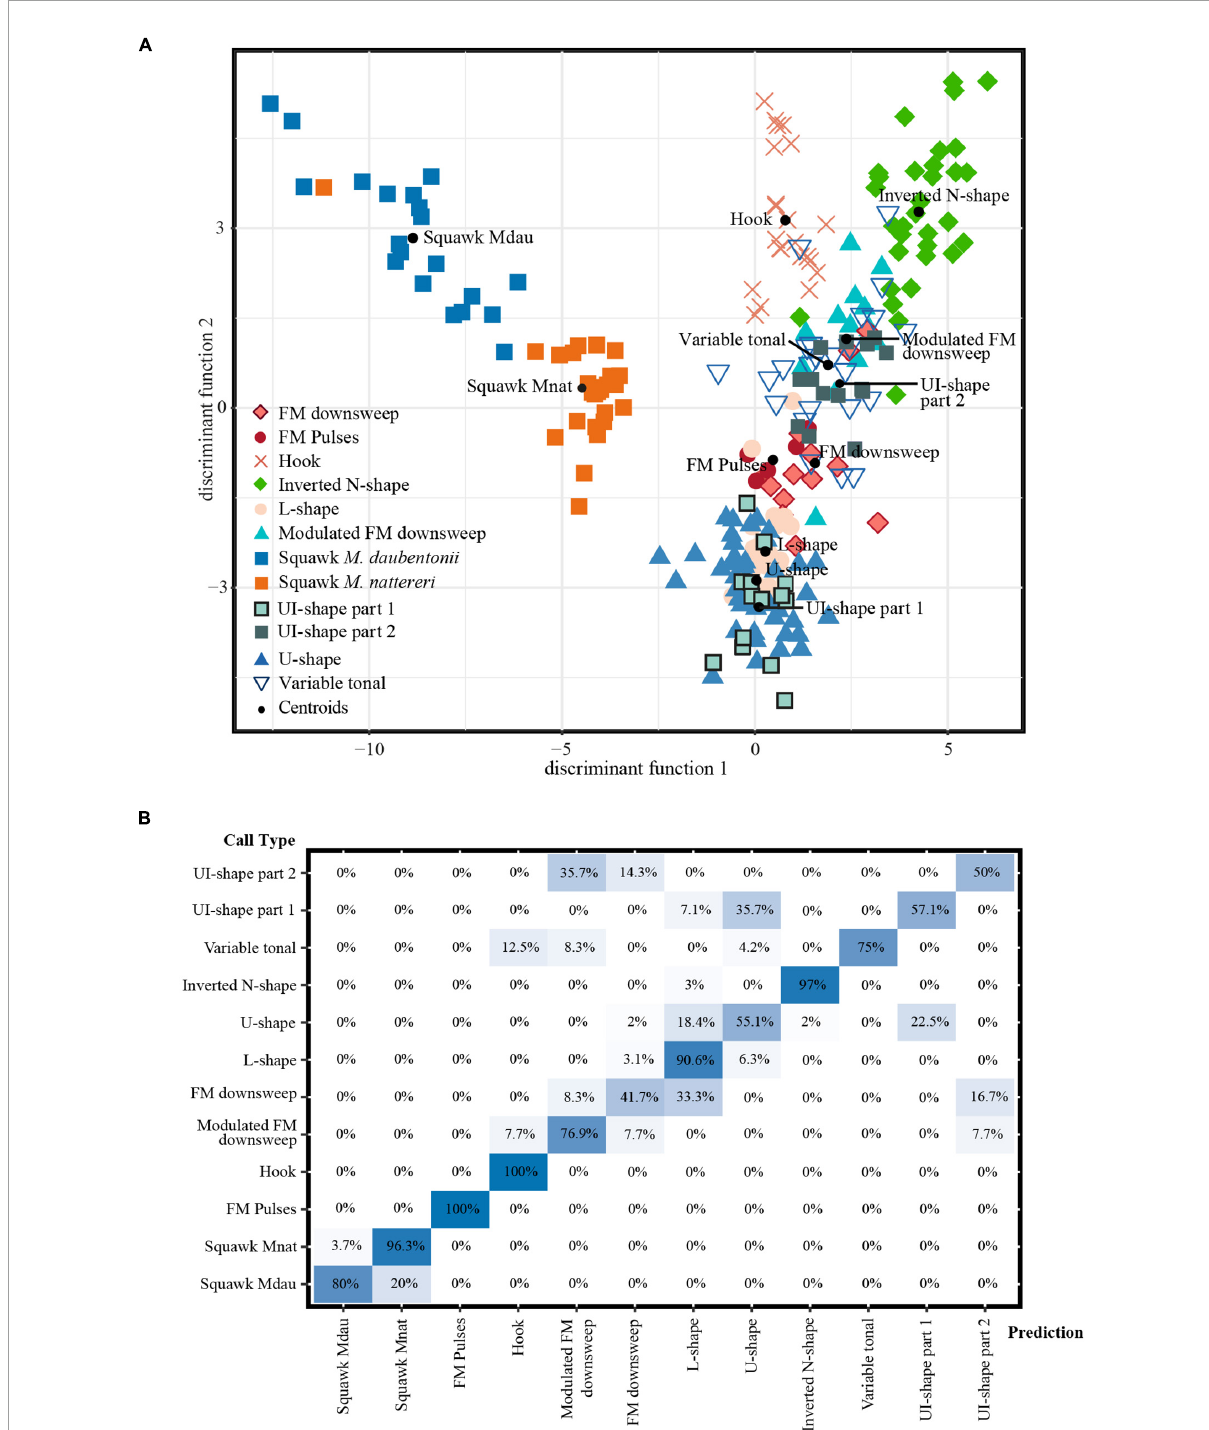
FIGURE4 (A) Relative position of social calls produced by swarming Myotis bats based on their spectral and temporal parameters. The two-dimensional signal space is defined by the first two discriminant functions, which were most important for call type discrimination. The ten call types are represented by different symbols; black circles depict centroids and are labeled with the respective call type. One call type, the squawk, was further discriminated by species because squawks were recorded from identified bats in crevices. All other calls were recorded from bats on the wing. One of those in-flight social calls, the combined UI-shape consisted of two different parts which were entered separately into the DFA. (B) Confusion Matrix indicating the call types to which analyzed calls were assigned. 77.4% of cross-validated cases could be classified correctly. Mdau, Myotis daubentonii ; Mnat, Myotis nattereri